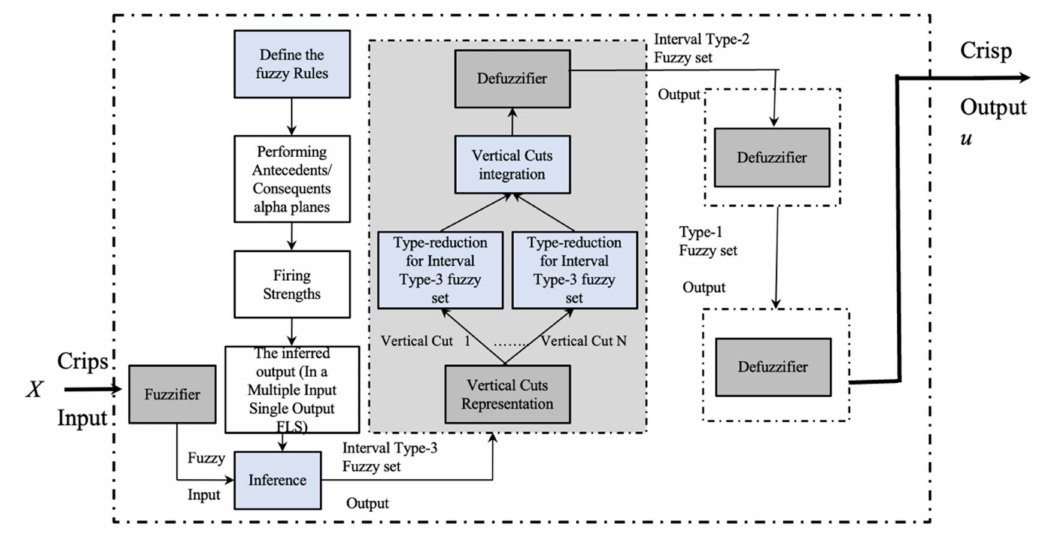
Figure 5. Structure of an